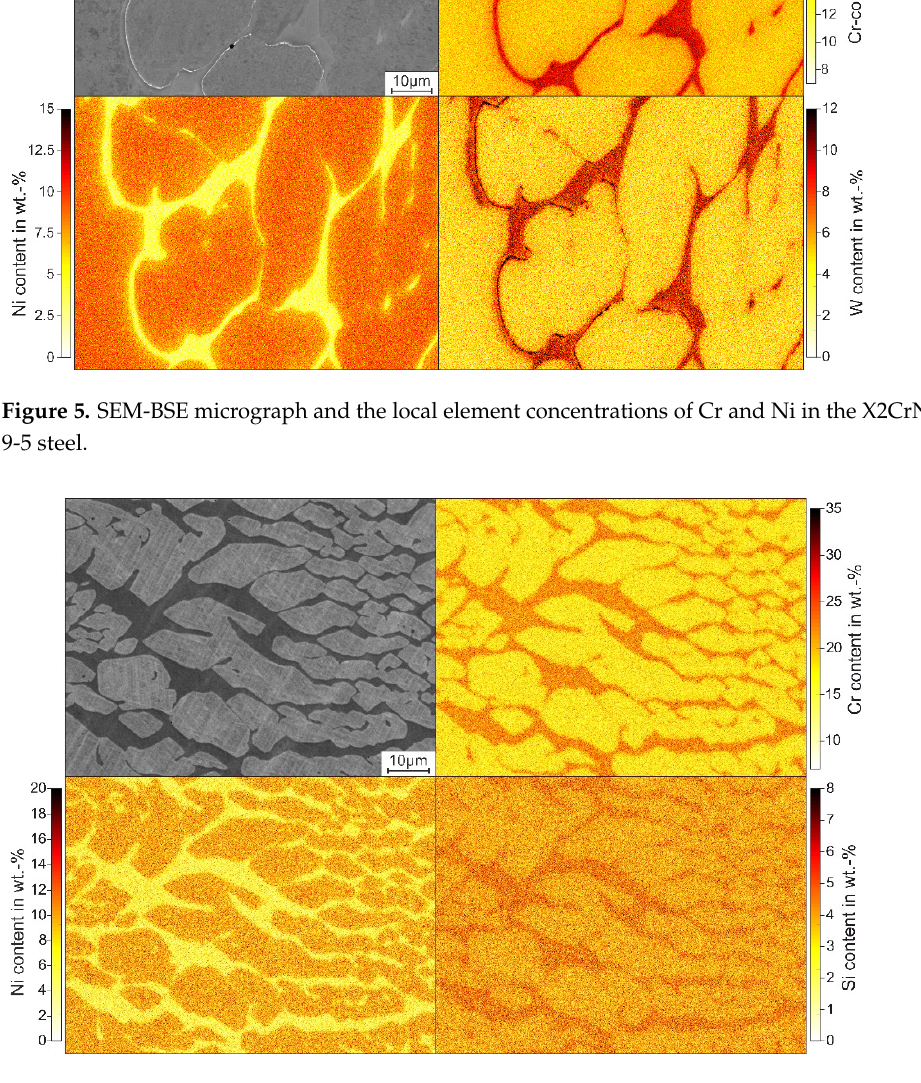
Figure 6. SEM ‐ BSE micrograph and the local element concentrations of Cr and Ni in the X2CrNiSi18 ‐ 9 ‐ 4 steel.